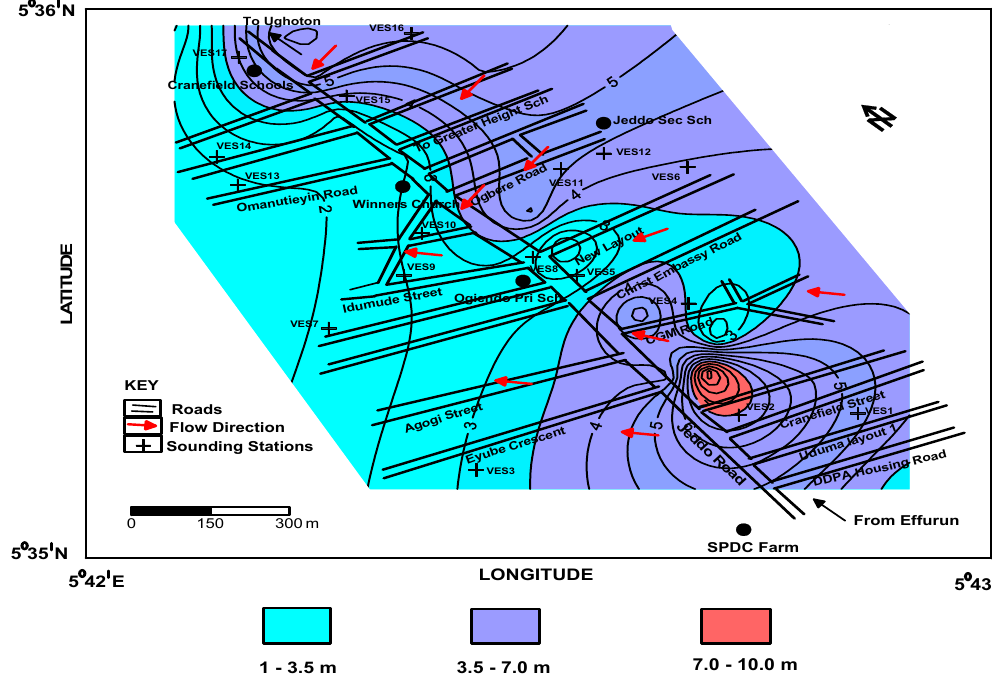
Figure 11. Map of static water level showing direction of flow.